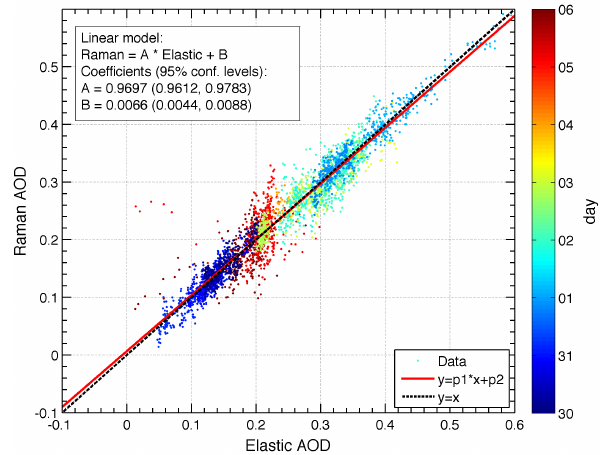
Figure 13. Aerosol optical depth at 355nm obtained from the Ra- man inversion is shown as a function of the optical depth from the Fig. 13. Aerosol optical depth at 355 nm obtained from the Raman inversion is shown as a function of the elastic inversion for 4435 nighttime cloud-free 1min profiles be- optical depth from the elastic inversion for 4435 nighttime cloud-free 1min profiles between 30 August and 6 September 2011. Colors indicate day of month. The two lines are the linear regression (continuous tween 30 August and 6 September 2011. Colors indicate day of red) and the reference y = x (dashed). month. The two lines are the linear regression (continuous red) and the reference y = x 46